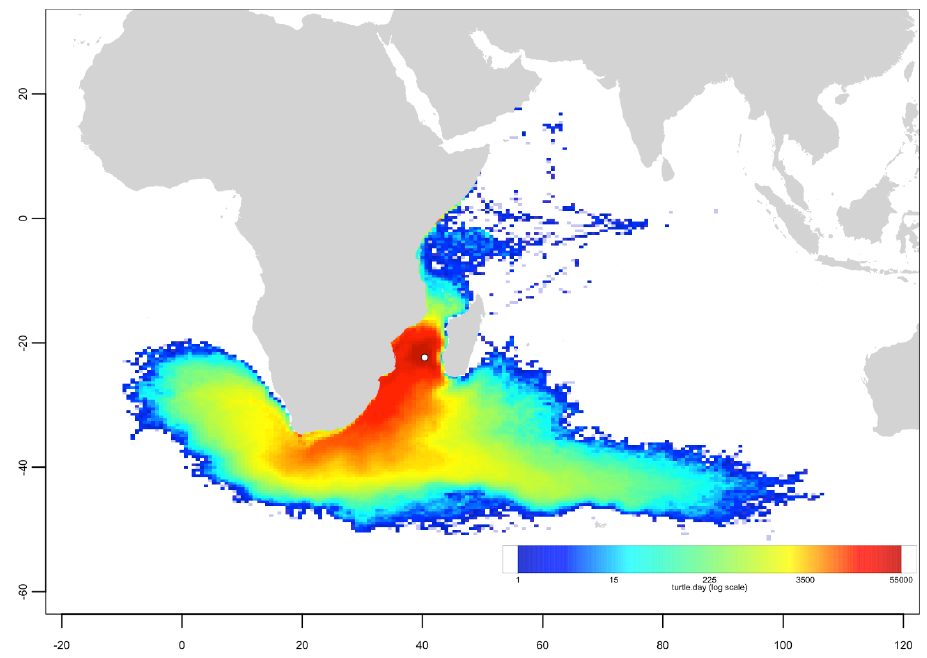
Figure A7. Europa dispersal map. One-year long trajectories of 10,000 particles released from a 0.25° × 0.25° areas located about 40 km off the main nesting beaches of Europa (with circle) from 2002 to 2006 (for a total of 50,000 particles). The color indicates the density of particles in number of turtles per day (log scale).